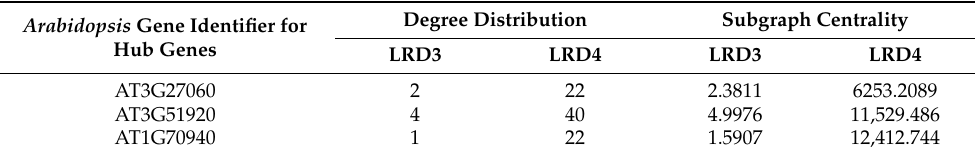
Table 2. Network measures for hub genes in the subnetworks for the cellular response to stimulus process under low radiation dose.